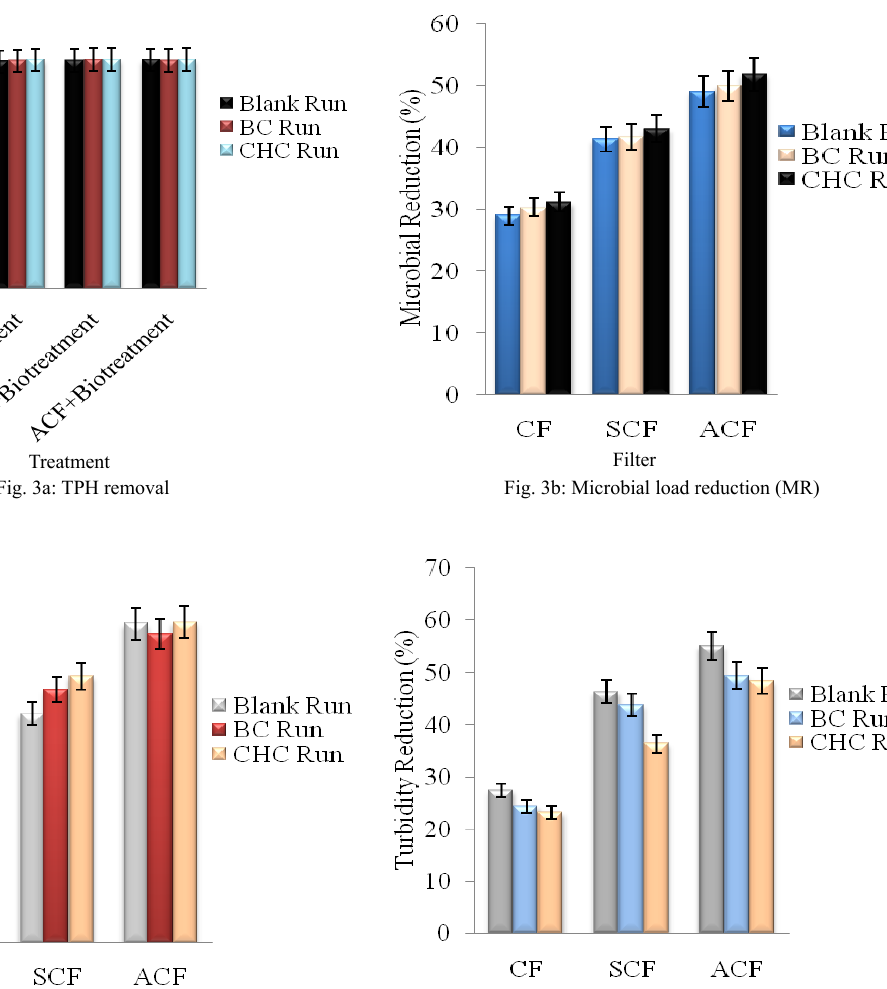
48.45±1.03 Table 4: Results for filter efficiency Filter